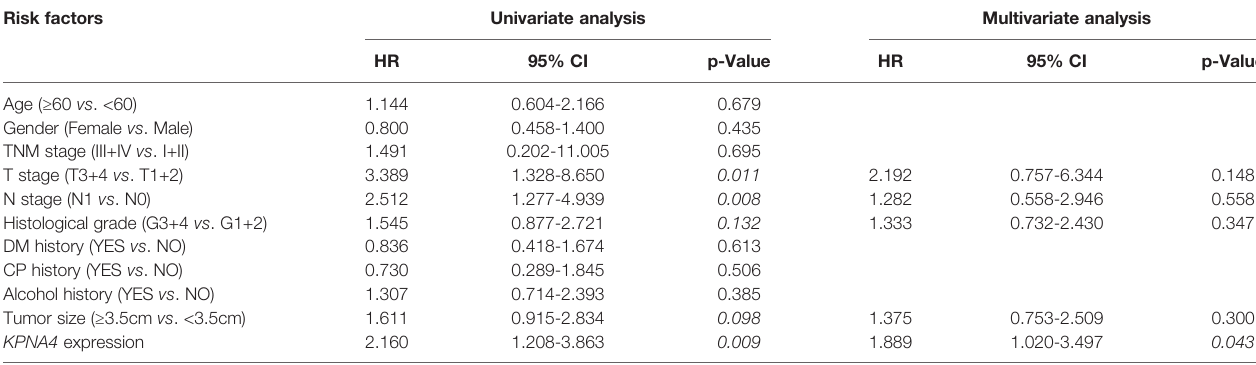
TABLE 2 | Univariate and multivariate Cox regression analyses of prognostic factors for overall survival in PDAC patients. Risk factors Univariate